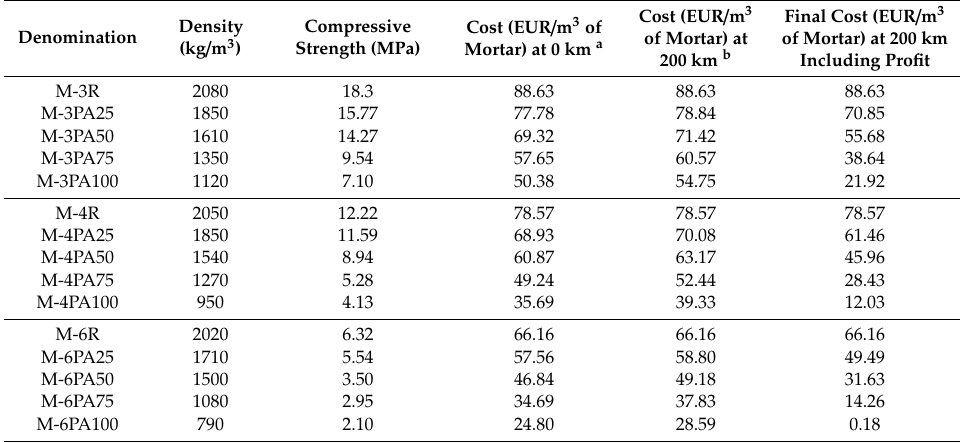
Table 16. Summary of the properties (density and compressive strength) and prices of the tested mortar